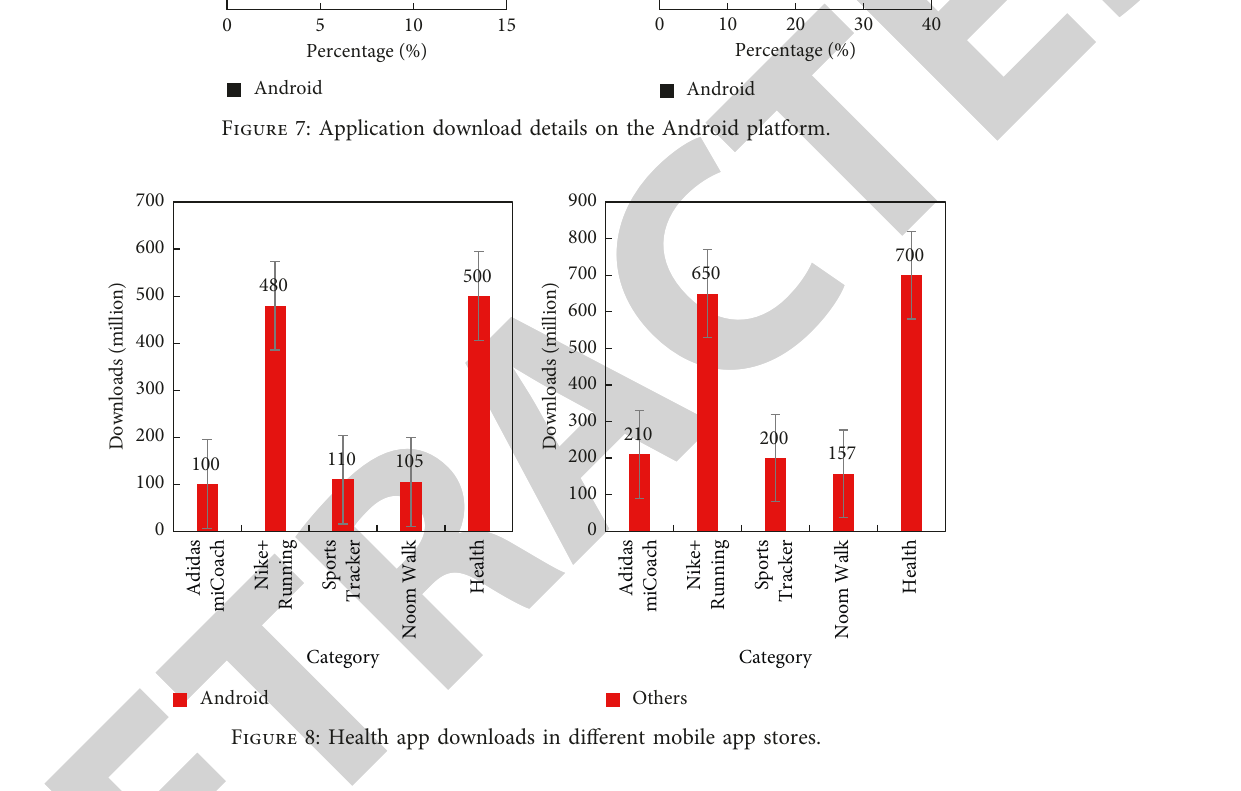
Figure 8: Health app downloads in different mobile app stores.